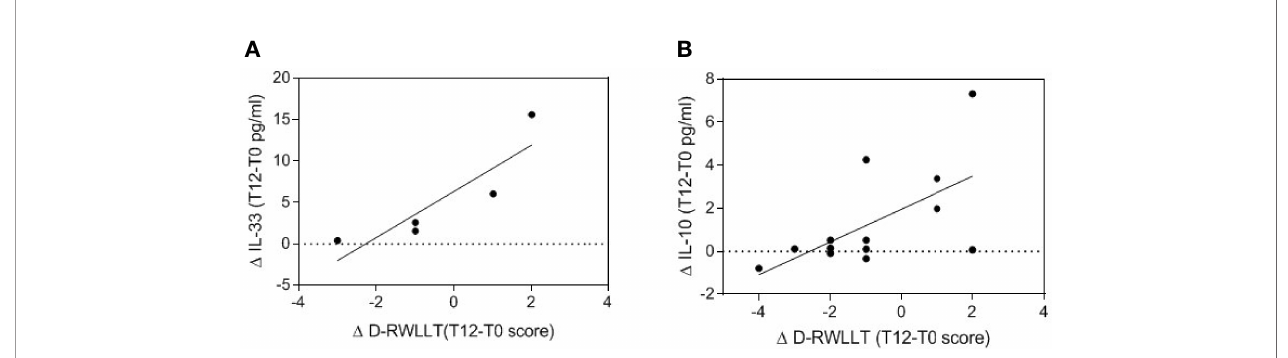
FIGURE 3 | Correlation between serum cytokine changes and episodic memory performances. The relationships between T12-T0 delta values of serum IL-33 ( A , n=5) or IL-10 ( B , n=14) and T12-T0 delta scores of delayed recall RWLLT are reported in the scatterplots, with lines representing linear